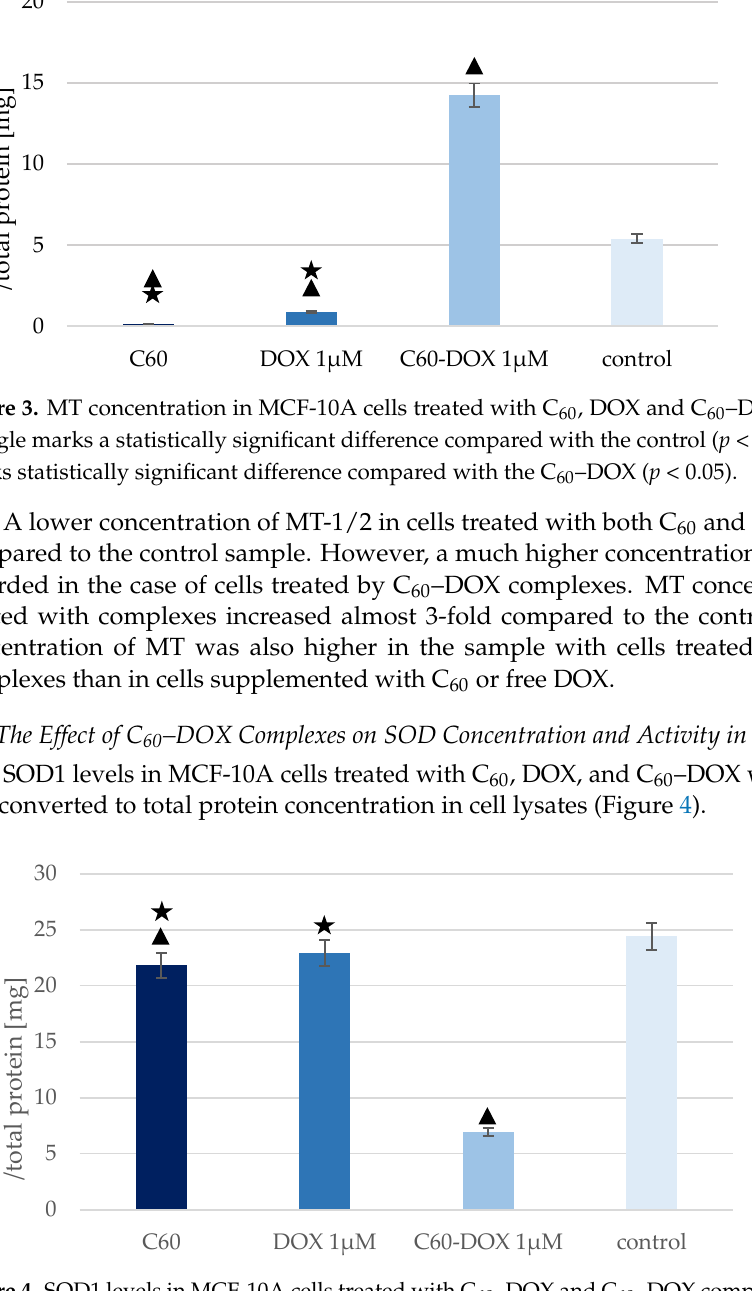
Figure 2. Biophysical characterisation of C 60 and complexes of C 60 -DOX. Particle size distribution diagram of the C 60 ( a ) and C 60 -DOX complexes ( b ). Zeta potential of C 60 ( c ) and C 60 -DOX complexes ( d ).